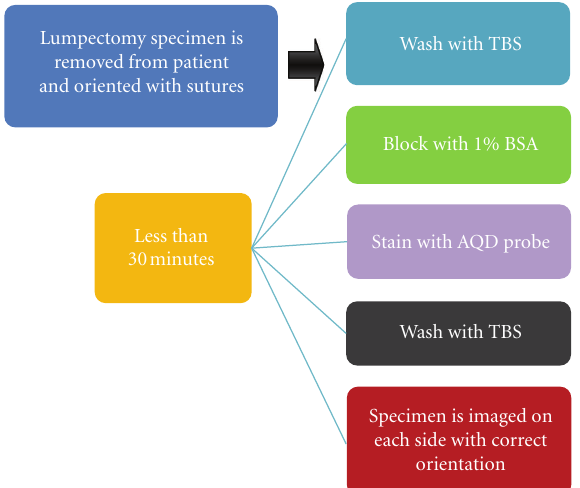
Figure 3: The proposed process of margin determination using AQD-Tn mAb